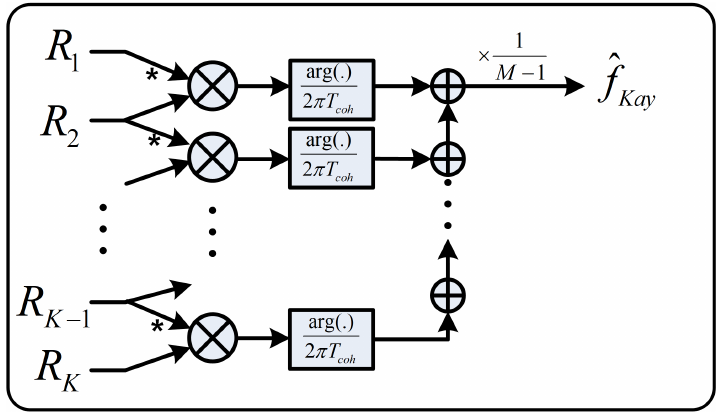
Figure 1. Classical Kay’s